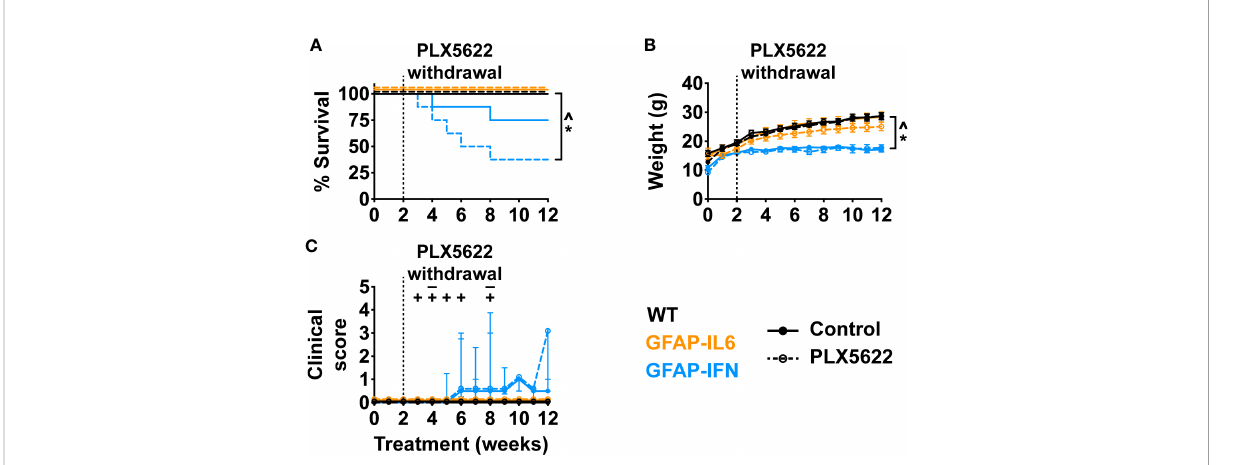
FIGURE 8 Ten weeks following PLX5622 withdrawal, GFAP-IFN mice recapitulate the clinical phenotype observed in chronic PLX5622-treated mice. (A) Survival, (B) weight and (C) clinical score of 1-month-old mice treated with control or PLX5622 diet for 2 weeks, followed by 10 weeks on control diet. Solid lines represent control diet-fed mice and dashed lines represent PLX5622 diet-fed mice. In (C) , the ‘–’ symbols indicate when untreated GFAP-IFN mice died and ‘ + ’ symbols indicate when PLX5622-treated GFAP-IFN animals died. n=7-16 mice/group. For (B) , graph shows mean ± SEM, for (C) , graph shows median + interquartile range. Signi fi cance of survival between genotypes and treatment groups was calculated by the log-rank test with Benjamini-Hochberg post-test. Signi fi cance of weight between genotypes and treatment groups was calculated with linear mixed-effects models and p-values adjusted with Tukey ’ s post-test. Signi fi cance of clinical scores between untreated and PLX5622-treated GFAP- IFN mice was calculated with cumulative link mixed models with p-values adjusted using the Bonferroni method. *p<0.05 compared with WT of same diet; ^p<0.05 compared with GFAP-IL6 of same diet; # p<0.05 compared with untreated control of same